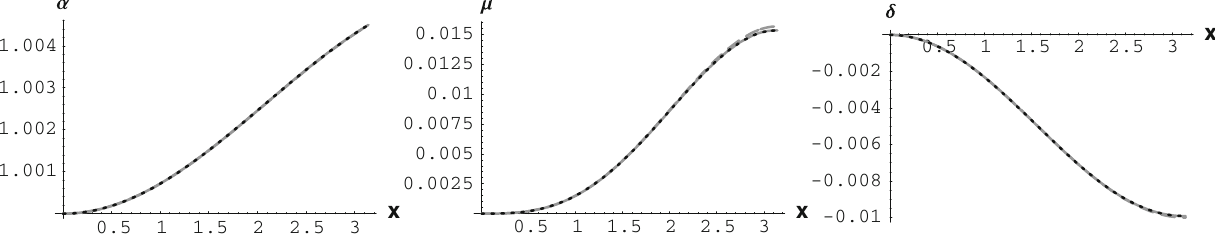
Fig. 6 Numerical solutions in the large coupling limit (dotted lines) and perturbative approximations (light dashed lines for the first-order approx- imations in (cid:2) and light solid lines for the second-order approximation in (cid:2) ) for α( x ) , μ( x ) , and δ( x ) on the interval [ 0 ,π ] , where g 2 = 0 . 1 and (cid:2) = 0 .